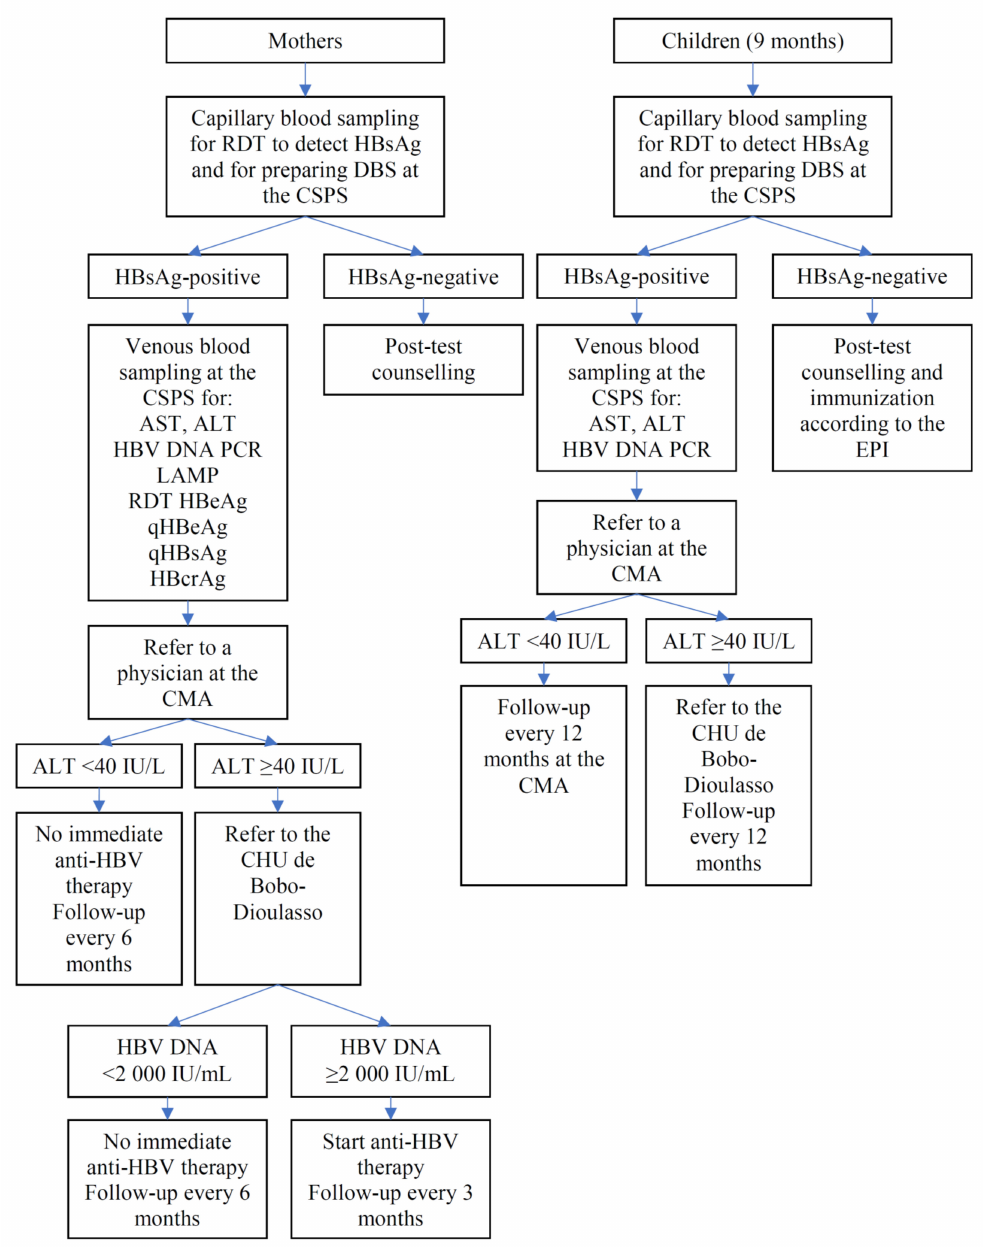
Figure 4. Algorithm for participants tested positive for HBsAg. Using assumptions (a) and (b), the number of children evaluated at 9 months of age in each observation period (3 weeks) in each cluster (CSPS) was estimated